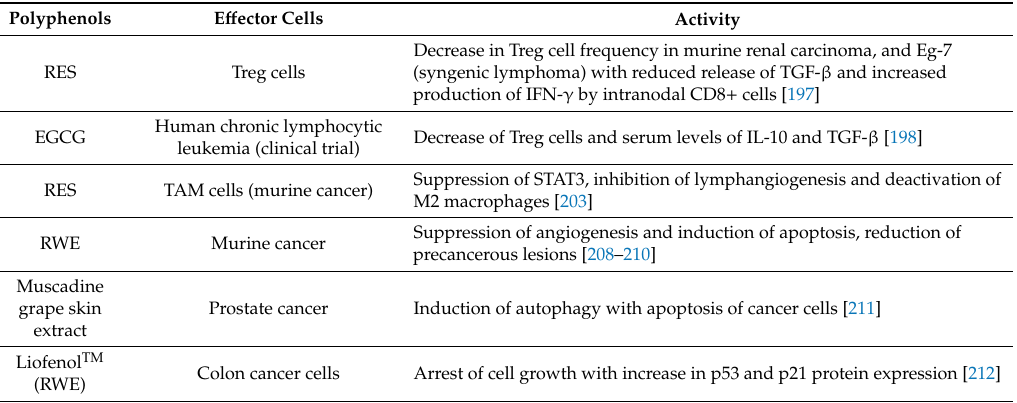
Table 6. Red grape polyphenol e ff ects on